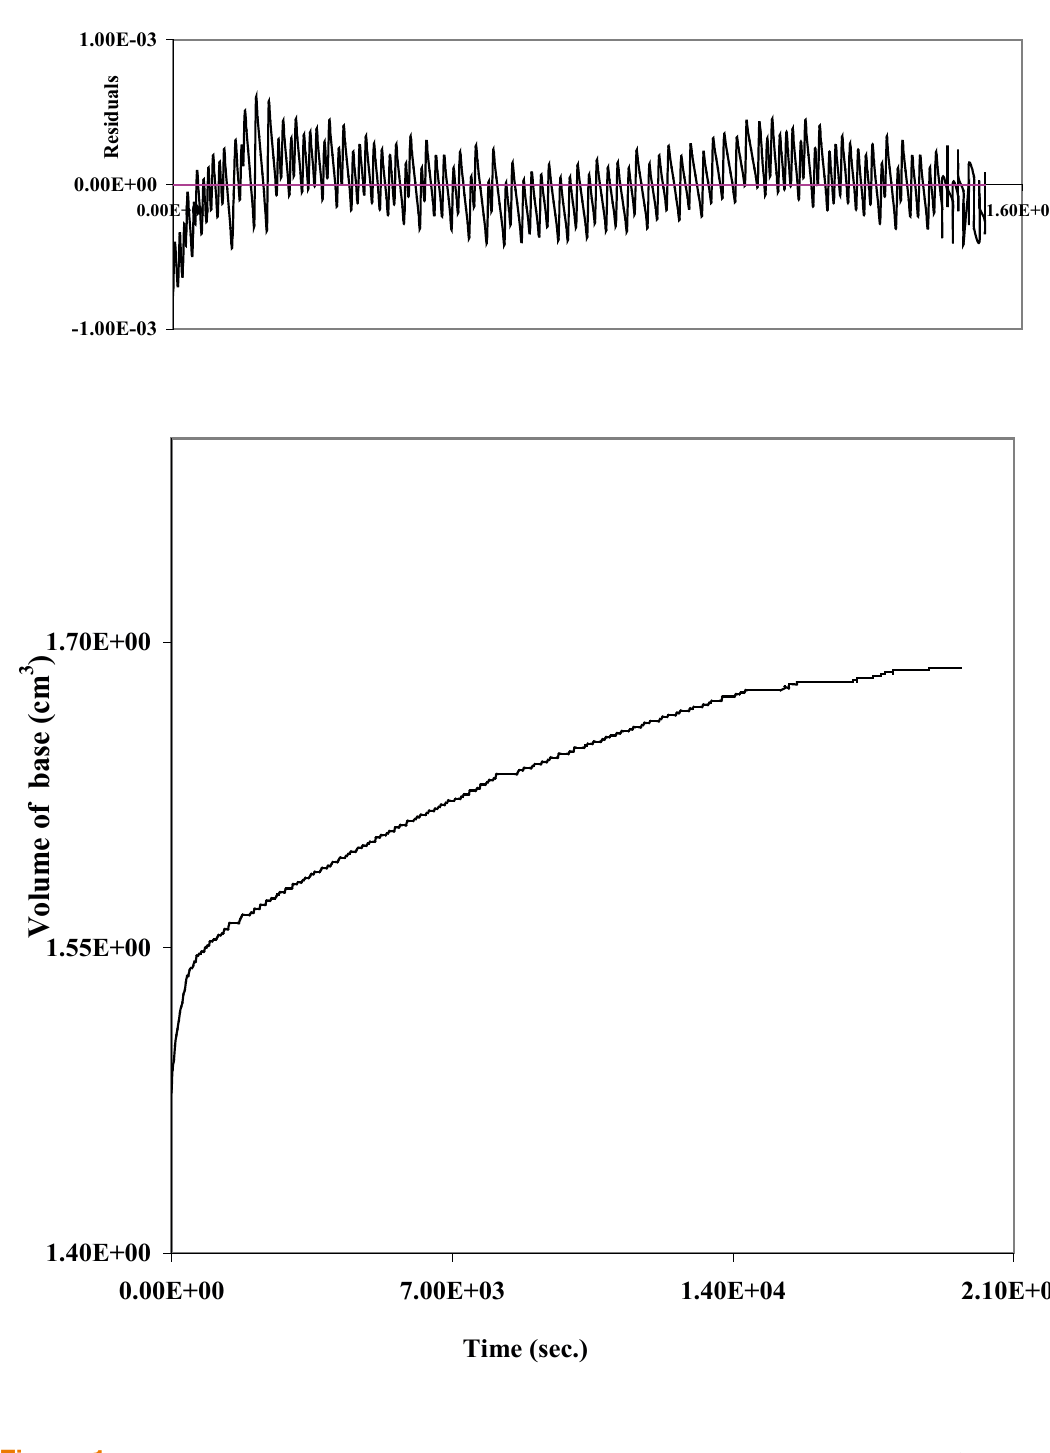
Figure 1. Typical volume of base vs. time trace, fitted with one exponential, for the hydrolysis reaction of [Pd(pip)GlyOMe] 2+ at 25°C and 0.1 M ionic